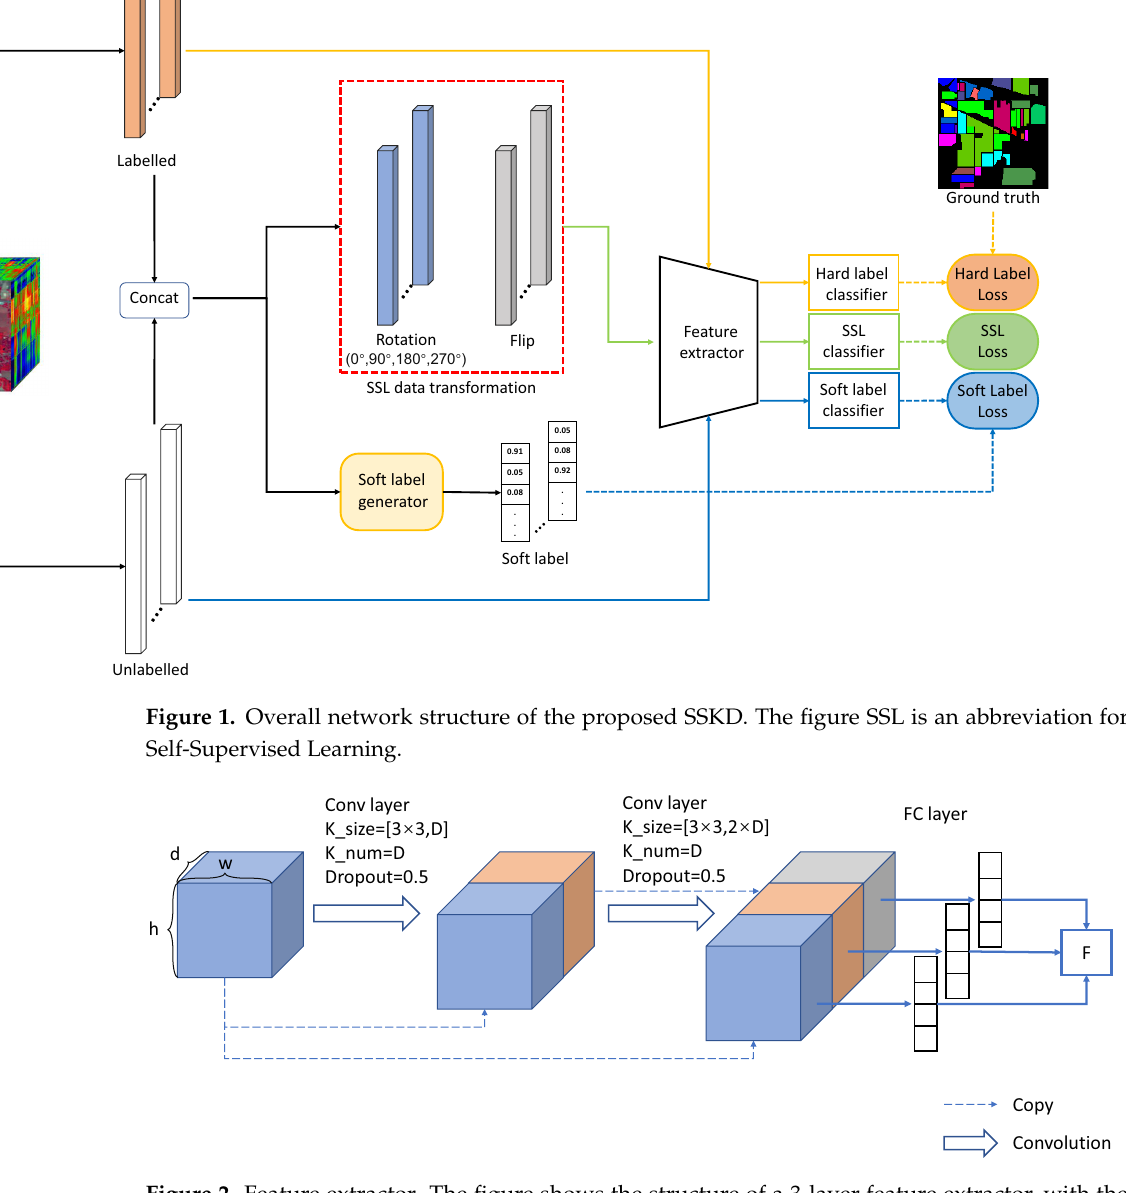
Figure 2. Feature extractor. The figure shows the structure of a 3-layer feature extractor, with the width, height and depth of the input data denoted by w, h and d. K_size and K_num denote the size and number of convolutional kernels, respectively. The F denotes multi-layer information fusion. The output of each layer of the network is represented by a new